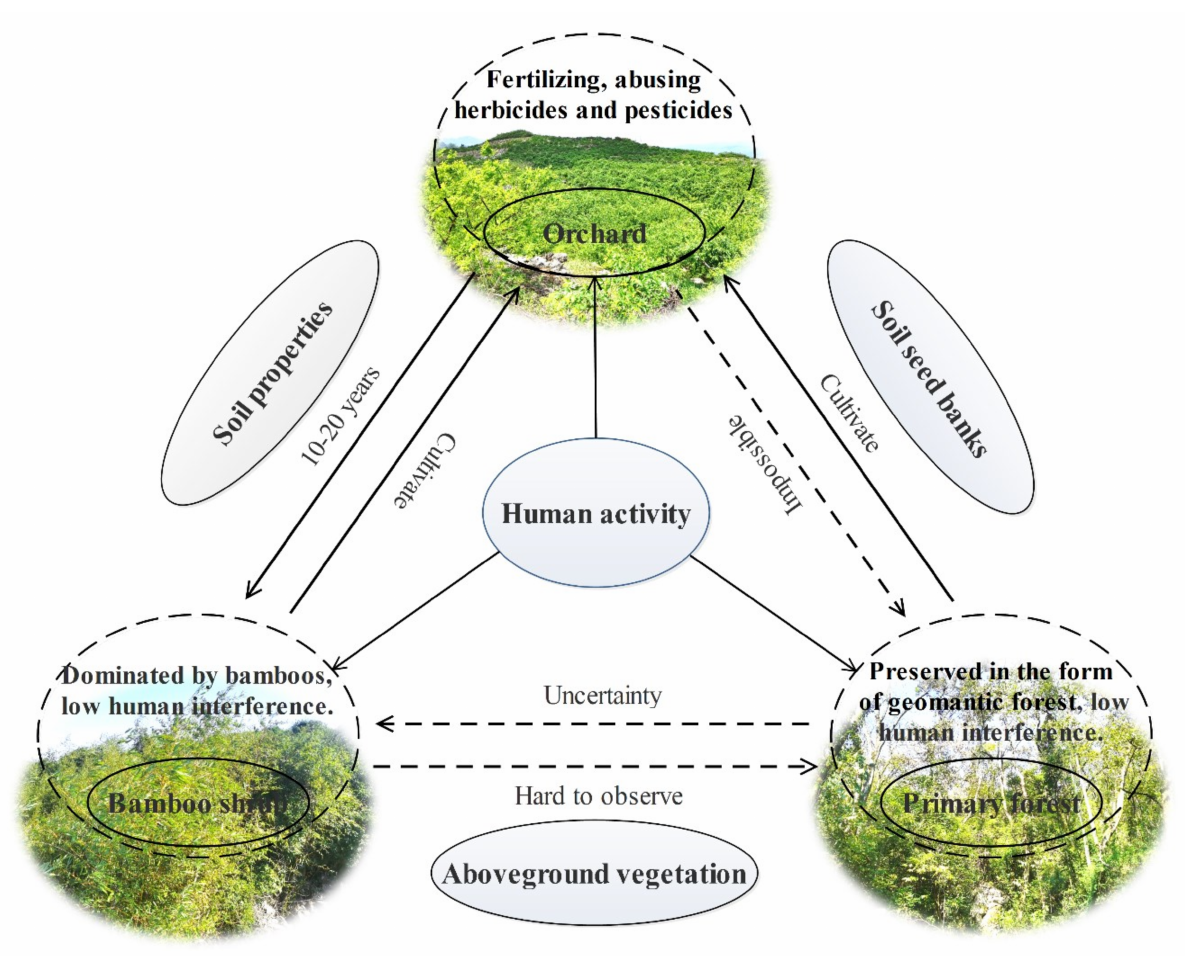
Figure 2. The characteristics of the three typical vegetation types and the interrelations between